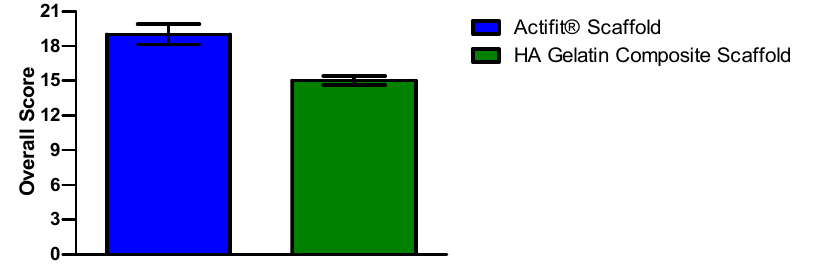
Figure 11. Overall Scoring Results of the different scaffolds. Error bars indicate 95% confidence interval.